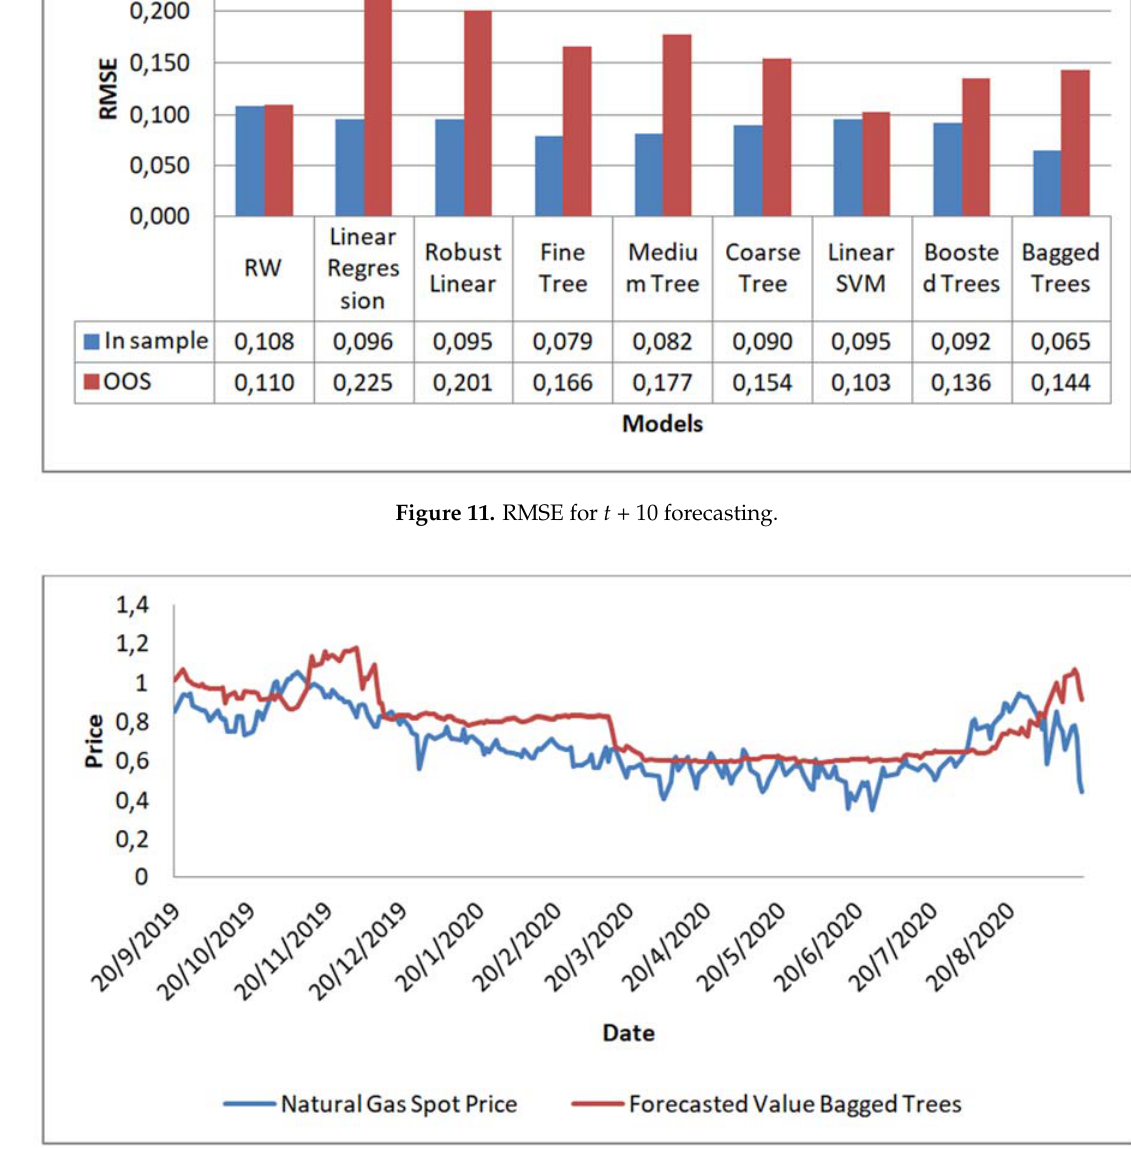
Figure 12. Comparison of the actual natural gas spot prices and the predicted prices with the bagged trees model for t + 10 in the out-of-sample part of the